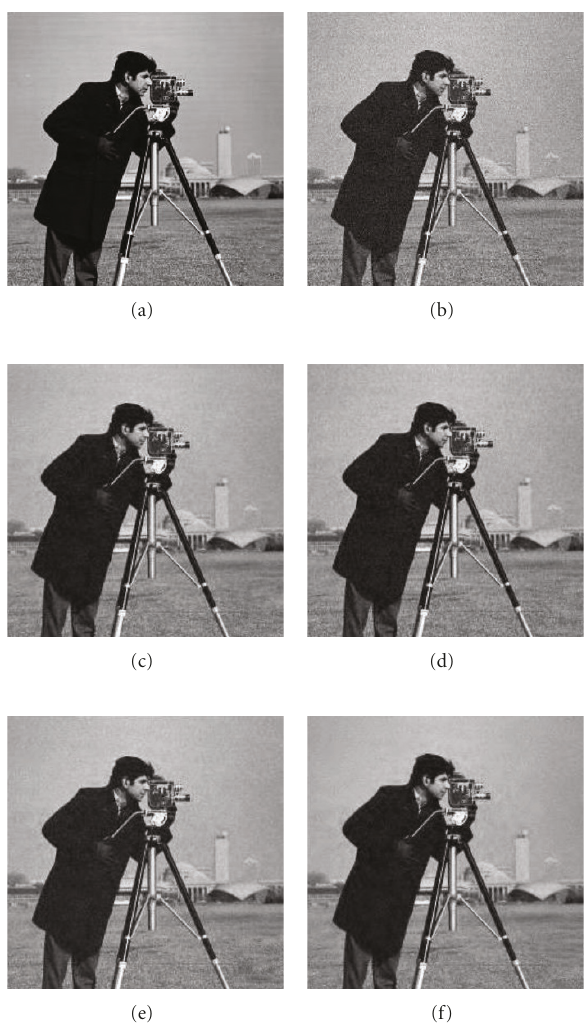
Figure 7: (a) Noiseless image, (b) Noisy image with σ w = 15, (c) Optimum soft thresholding, (d) Bayeshrink, (e) Sureshrink, (f) MNDL soft